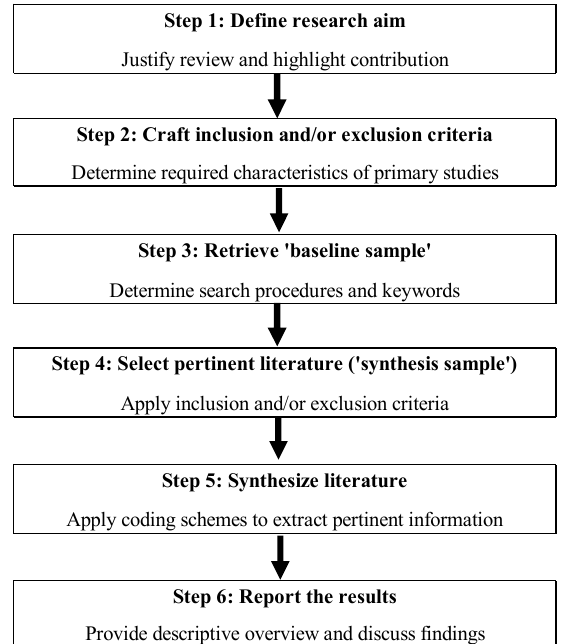
Figure 1. Steps for conducting a systematic literature review (adapted from Durach et al. [18]). Table 1. Inclusion